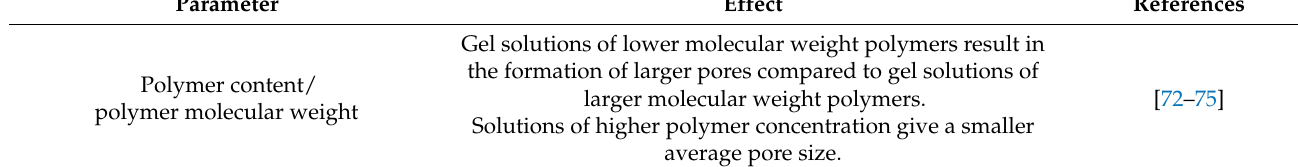
Table 3. Adjustable process parameters of cryogel synthesis and their effects on cryogel features [8,9].